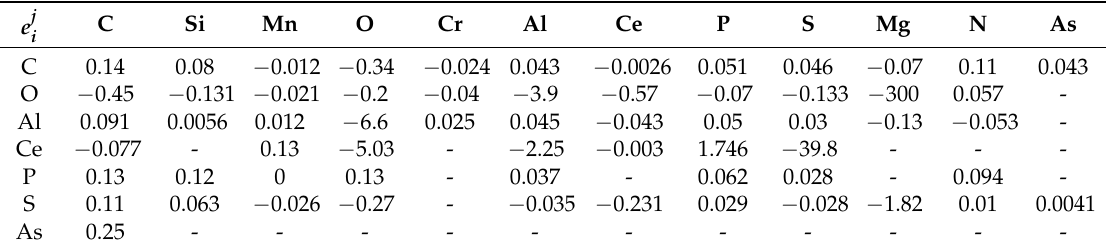
Table 2. Interaction coefficients at 1873 K [14,15].